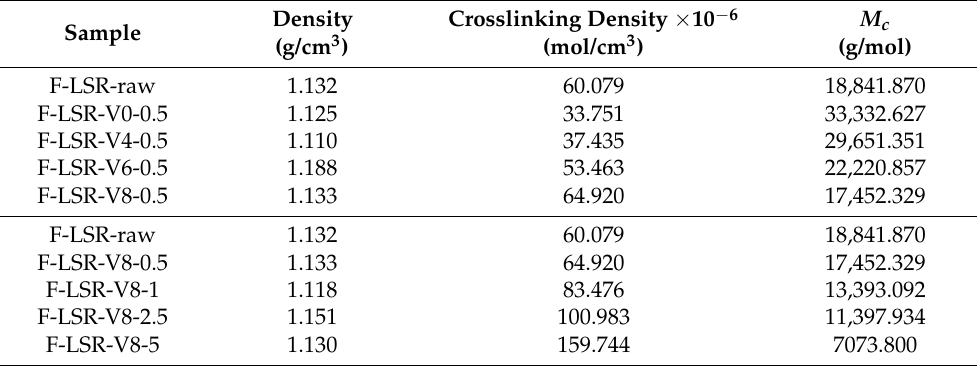
Table 3. Densities, crosslinking densities, and M c values for the F-LSR-POSSs.